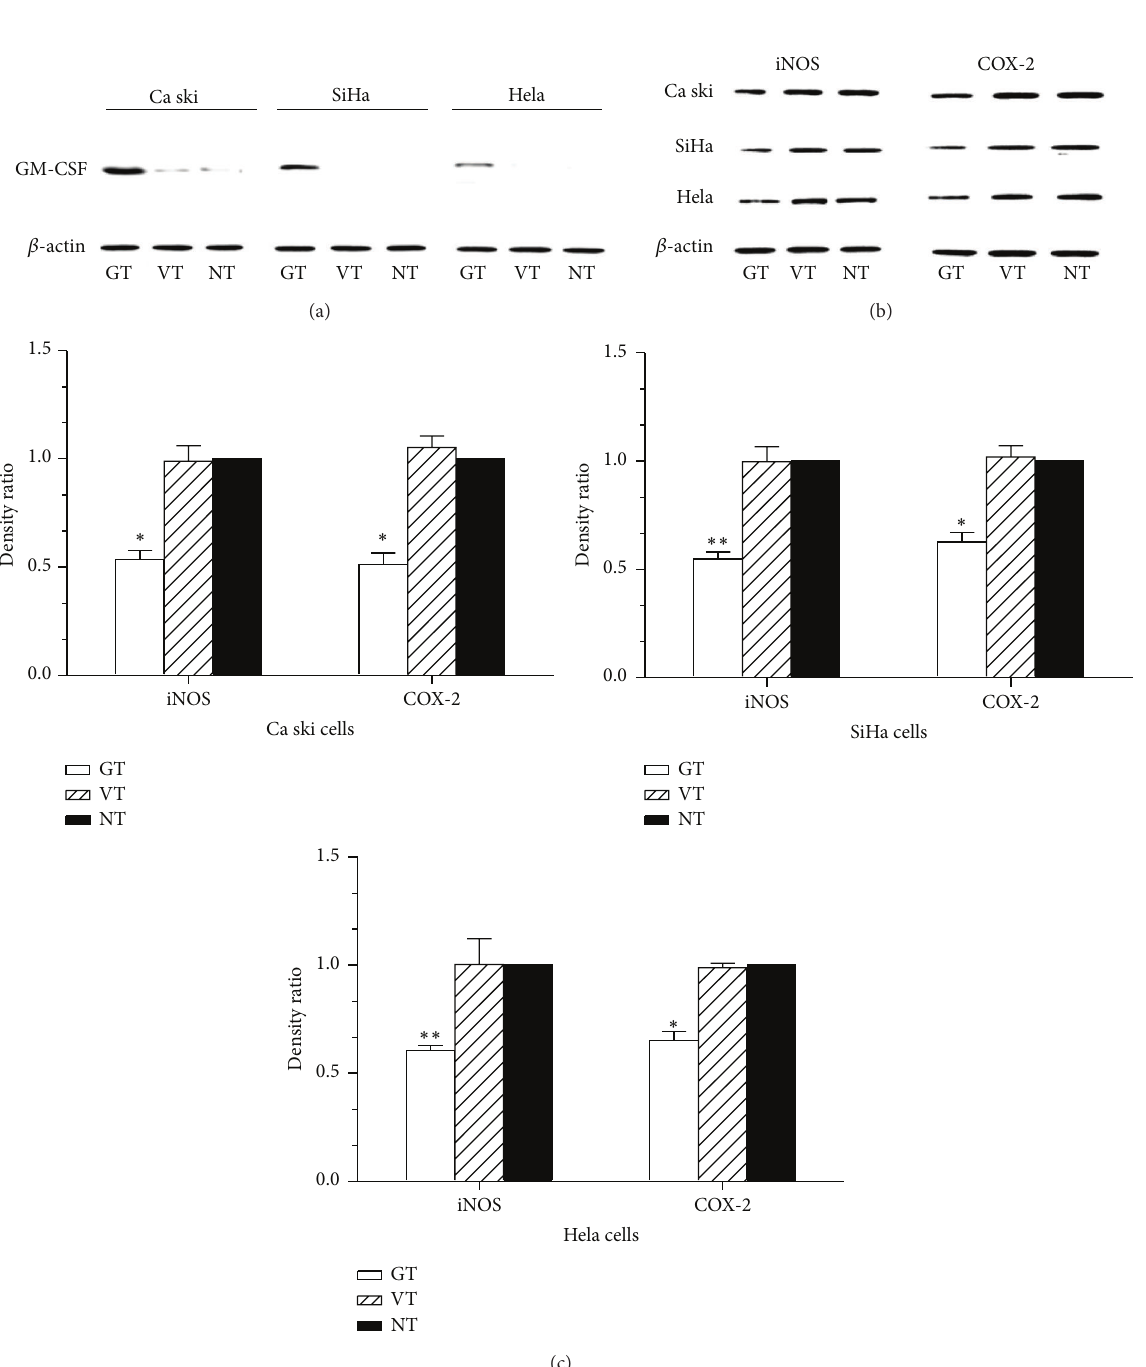
factors, which may explain why we did not observe any correlation between HPV infection and the expression of GM-CSF, iNOS, or COX-2 in our clinical cervical cancer tissue samples. Moreover, our finding of no HPV correlation